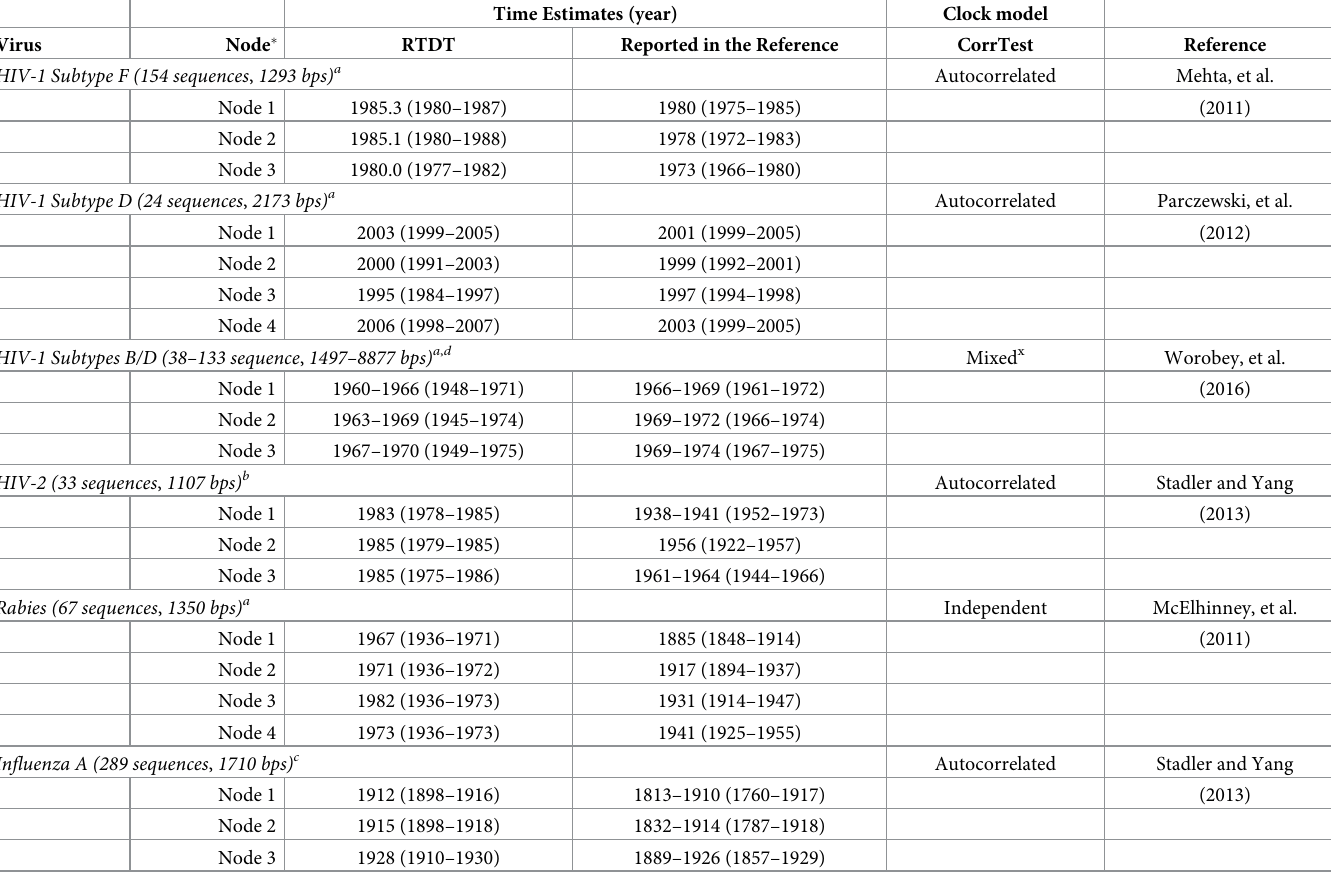
Table 1. Empirical datasets used in this